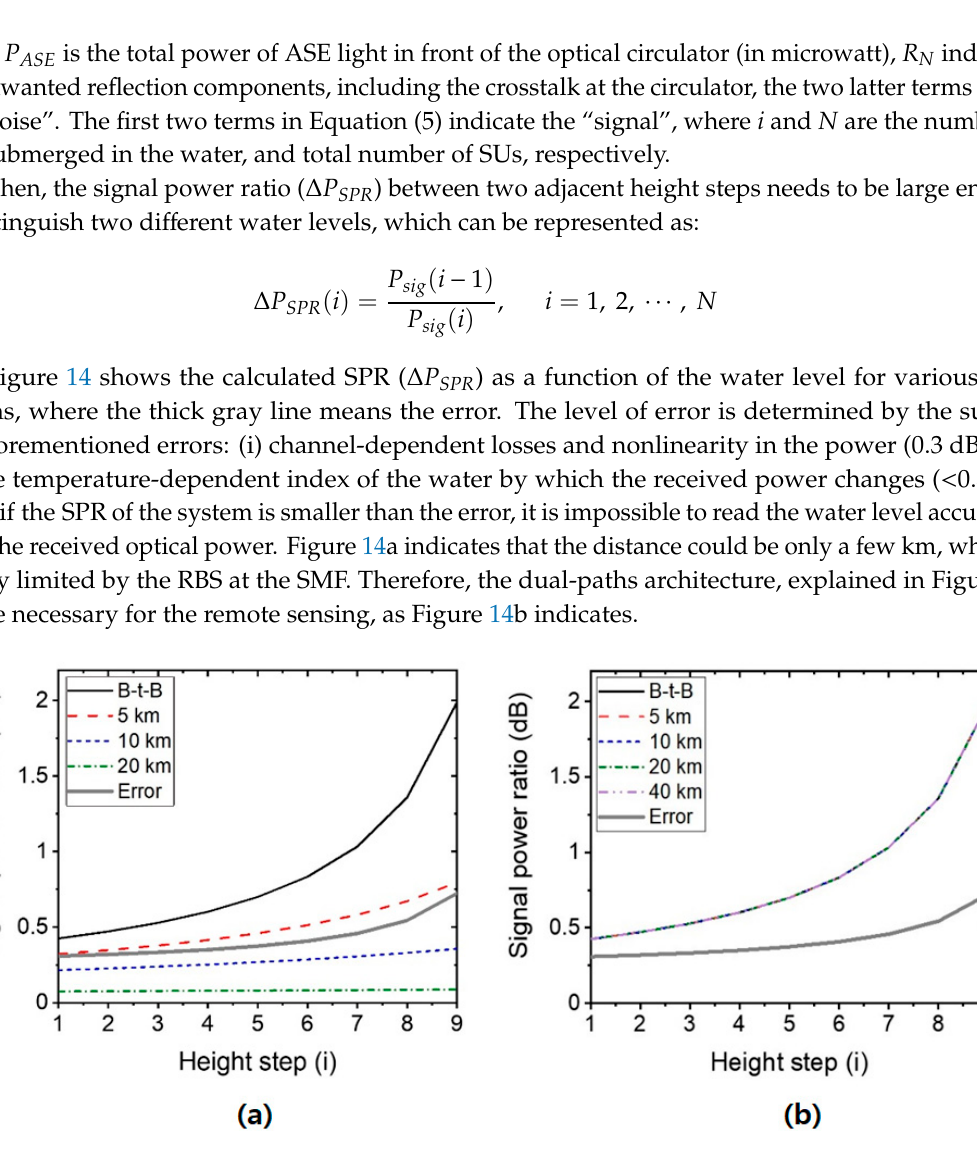
Figure 14. Calculated signal power ratio (SPR) as a function of the height steps for various fiber lengths: ( a ) in loop-back architecture and ( b ) dual-paths architecture, where the RBS effect is eliminated. B-t-B: Back-to-Back.